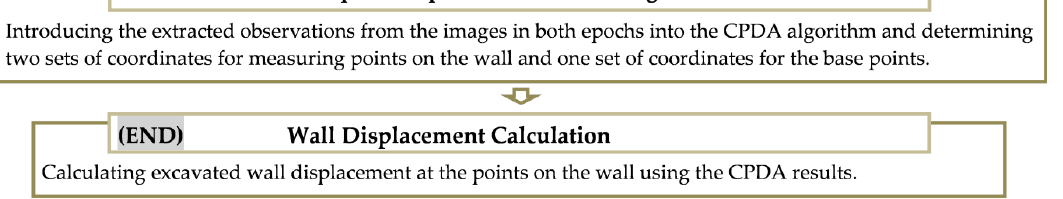
Figure 3. The flow of implementing a UAV photogrammetry system for displacement measurement of a structure.